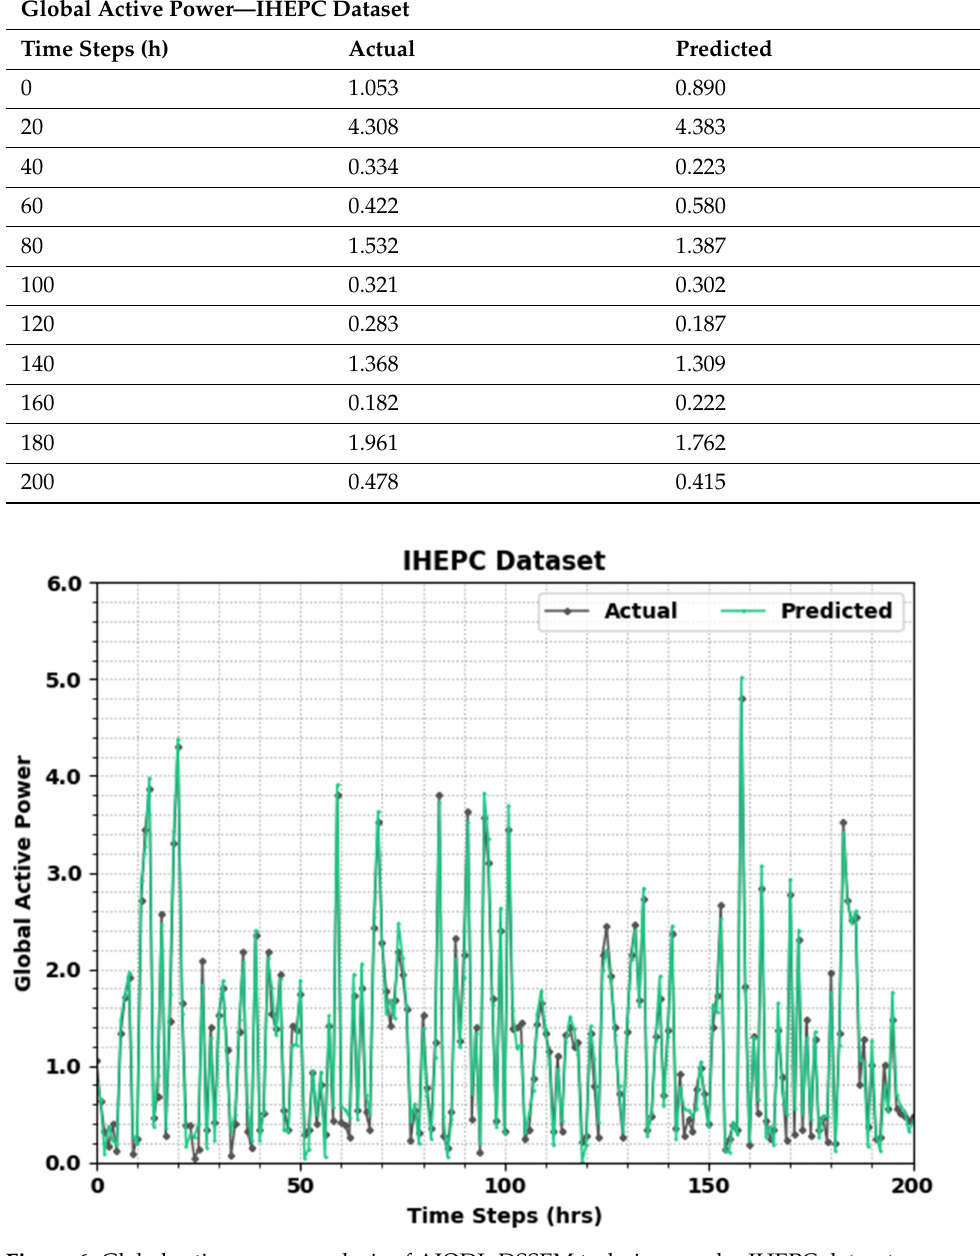
Figure 6. Global active power analysis of AJODL-DSSEM technique under IHEPC